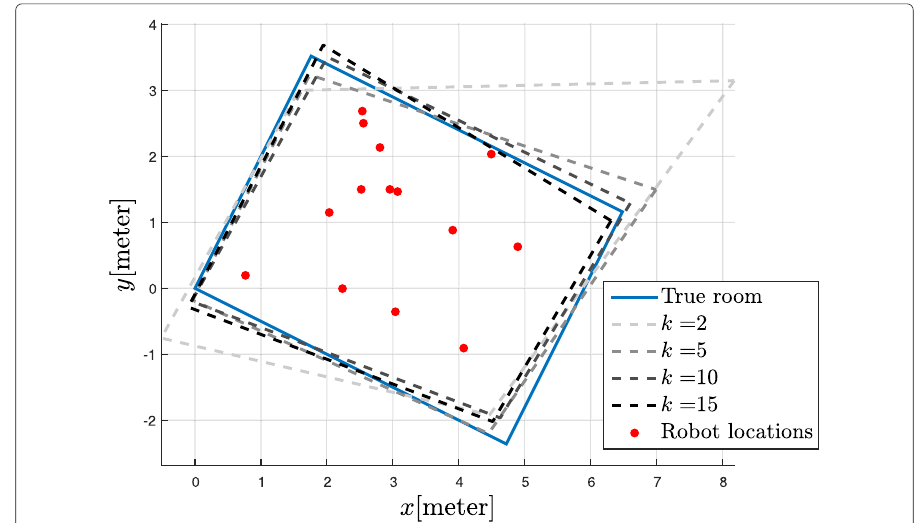
Fig. 8 The estimated room geometry (in meters) via the EKF algorithm at steps k =